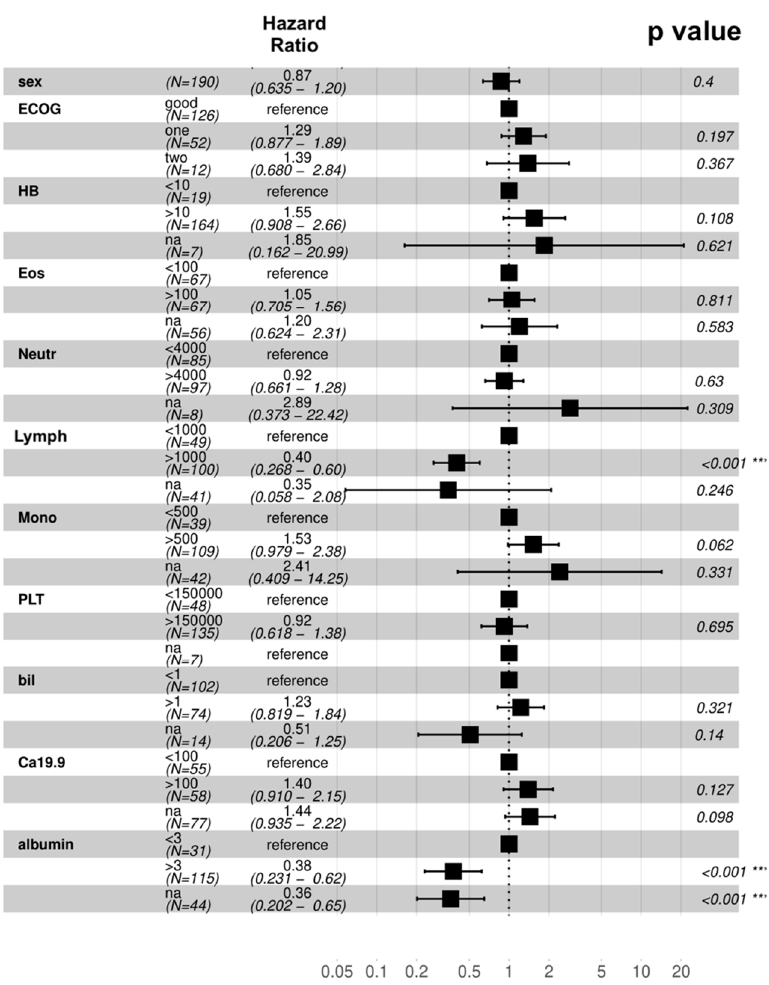
Figure 3. Univariate analysis of overall survival. Abbreviations: Bil—total bilirubin; Eos—eosinophil count; HB—hemoglobin; Lymph—lymphocyte count; Mon—monocyte count; Neutr—neutrophil count; PLT—platelet count. *** statistically significant results.